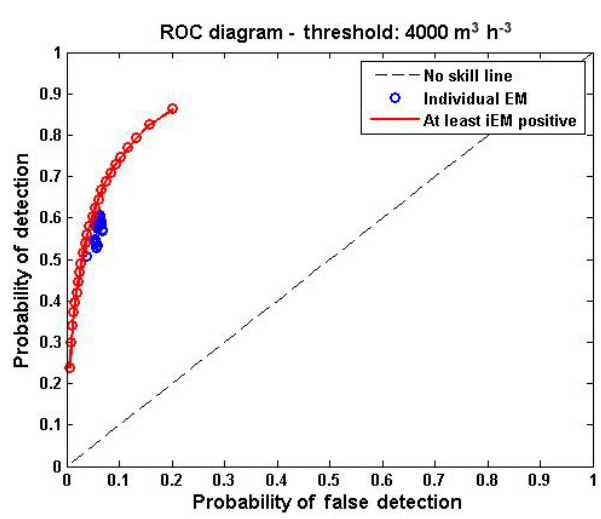
Figure 4. Example of a relative operating characteristic (ROC) dia-